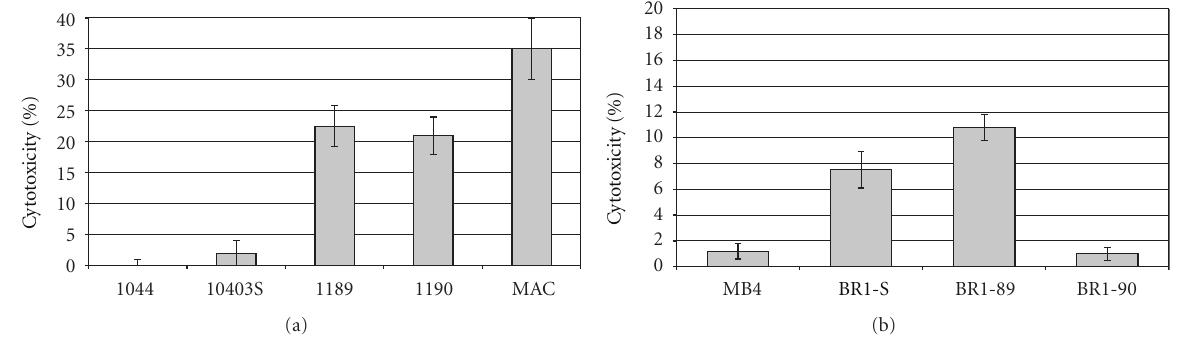
Figure 3: Cytotoxicity of L. monocytogenes (a) and B. subtilis (b) strains supernatants on Jurkat cells. Cytotoxicity of bacterial strain supernatants on the Jurkat cell line. Listeria monocytogenes (a) and Bacillus subtilis (b) supernatants were added to Jurkat cell cultures, and incubated for 1 h or 30 min, respectively. Eukaryotic cells were stained for viability, and after 30 minutes were observed under fluorescent microscope. The DP-Soft program was used to determine the level of cytotoxicity induced by proteins produced by the bacterial strains. The bars indicate the means of the counts from three independent experiments, and the bars show the standard deviations. Table 5: Survival of PBMC cells of healthy persons treated with di ff erent concentrations of B. subtilis supernatants.